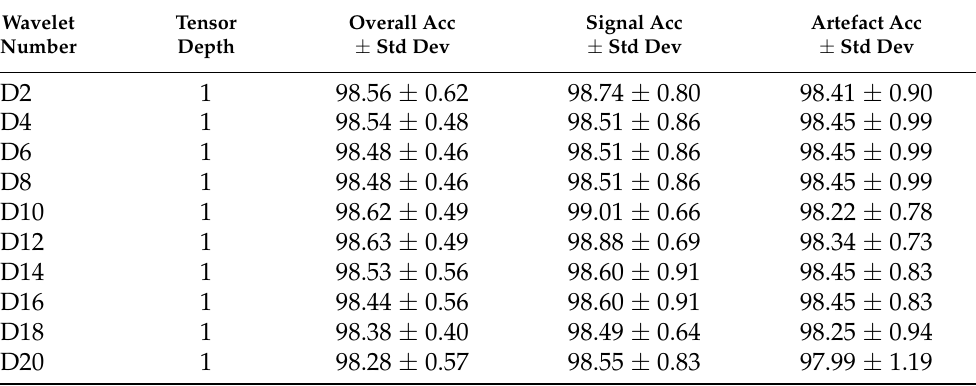
Table 5. CNN model performance for various single wavelet transformations applied to input data. Results have been estimated using repeated k-fold validation (5 rounds with 5 folds